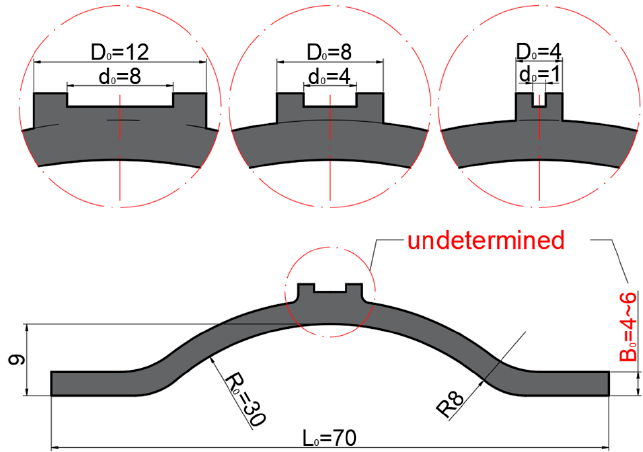
Figure 1. Shape and size of the diaphragm with three kinds of the stem loading surface parameter.